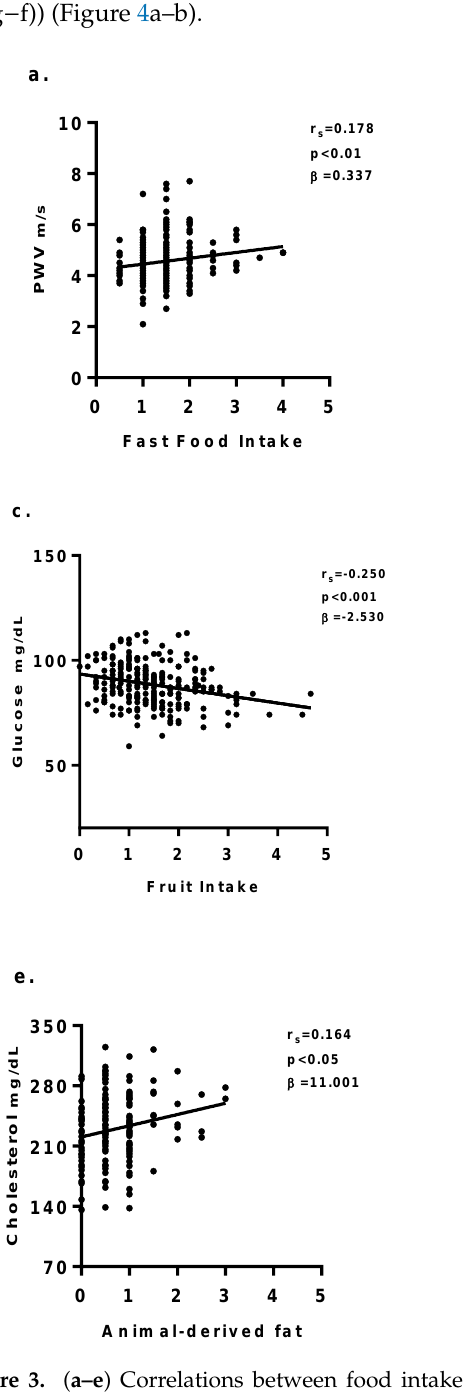
Figure 3. ( a–e ) Correlations between food intake and hemodynamic and gluco-lipid parameters. Figure 3. (a–e). Correlations between food intake and hemodynamic and gluco-lipid parameters. Correlation between: fast food intake and PWV ( a ); vegetables intake and glucose ( b ); fruit intake and Correlation between: fast food intake and PWV (a.); vegetables intake and glucose (b.) ; fruit intake glucose ( c ); nuts intake and glucose ( d ); animal-derived fat and cholesterol ( e ). PWV: Pulse Wave and glucose (c.); nuts intake and glucose (d.) ; animal-derived fat and cholesterol (e.) . PWV: Pulse Wave Velocity.